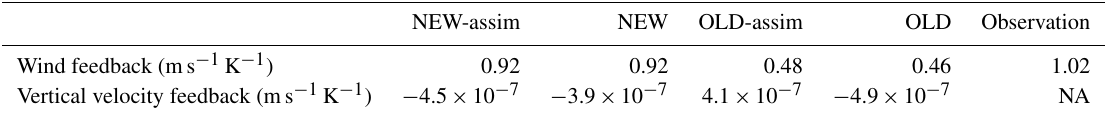
Table 3. The wind feedback and the vertical velocity feedback in NEW-assim, NEW, OLD, and OLD-assim. The wind feedback is computed as the monthly 10m zonal wind anomalies in the Niño4 region regressed onto the monthly NINO3-SST anomalies, and the vertical velocity feedback is the monthly vertical velocity anomalies at the depth of the 20 ◦ C isotherm in the Niño3 region regressed onto the monthly NINO3-SST anomalies. The wind feedback is also evaluated from the observation dataset.